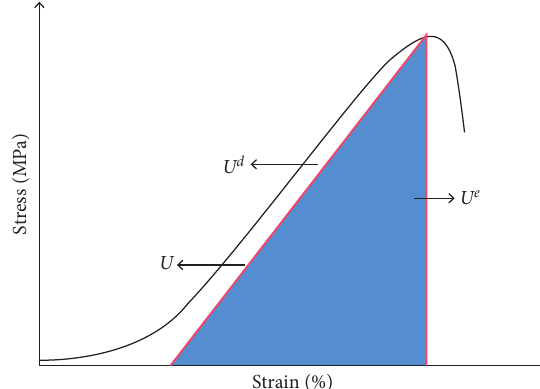
Figure 8: Relationship between the dissipated energy and the elastic energy of the rock